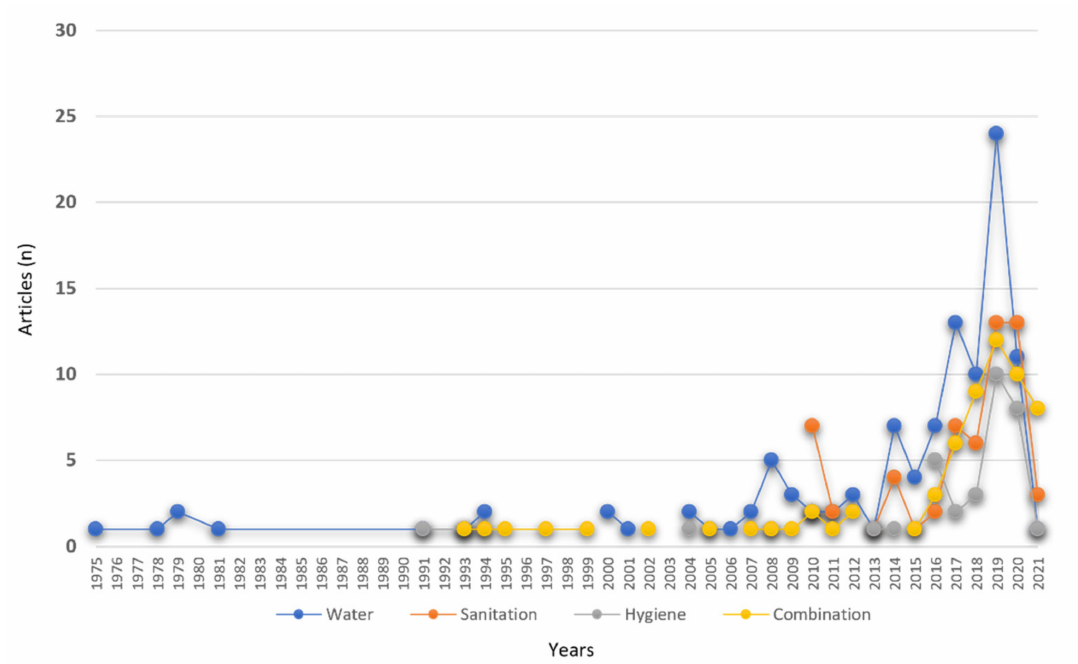
Figure 4. Growth of WASH research amount in Indonesia from 1975 to